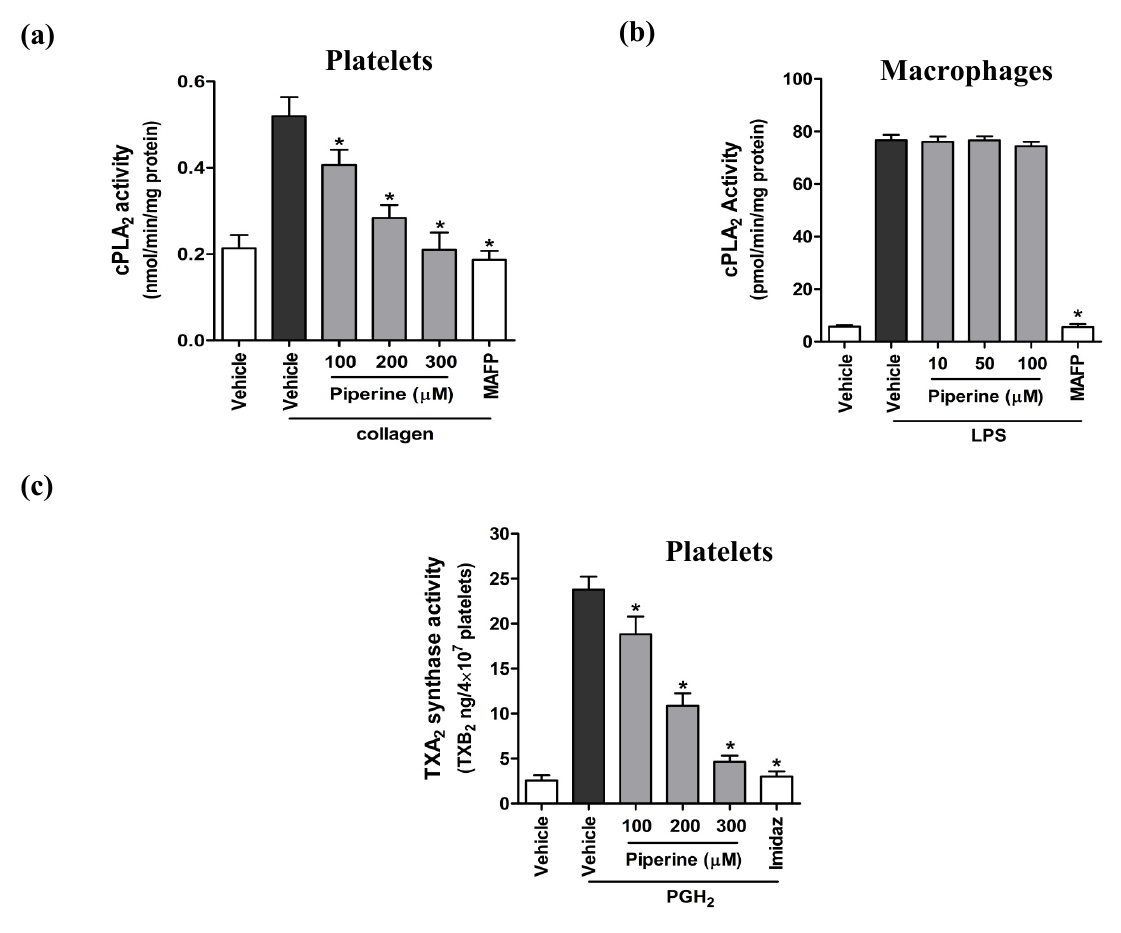
Figure 4. Piperine inhibited the activities of cPLA RAW264.7 cells. Platelets and RAW264.7 cells were treated with a range of concentrations of piperine (gray bars), vehicle (DMSO, white and black bars), or 10 μ M MAFP (a cPLA inhibitor), as presented in the graphs. cPLA collagen ( a ) and RAW264.7 cells stimulated by 1 μ g/mL LPS ( b ) was measured as described in the Materials and Methods section. TXA measuring the production of TXB measured in the presence of piperine or 50 mM imidazole (a TXA Data are expressed as means ± S.D. ( n = 3). * p < 0.05 vs. vehicle controls (black